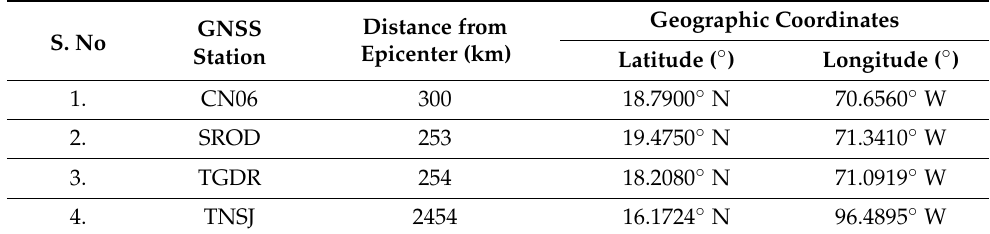
Table 2. Detailed information about the IGS stations and their distances from the epicenter. S. No